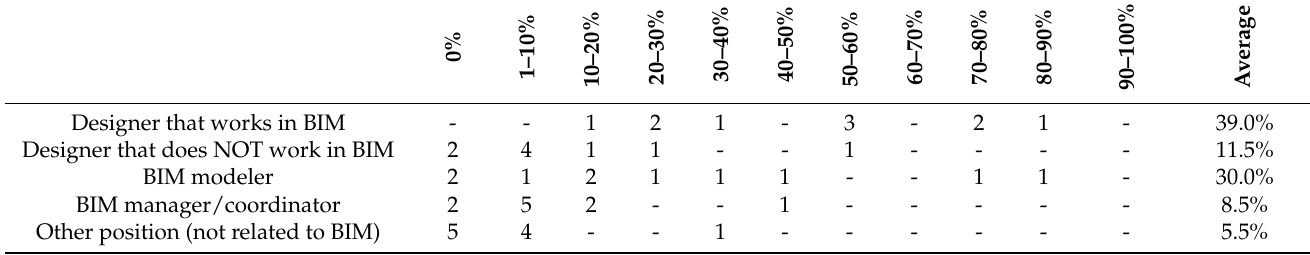
Table 4. Responses to the question: “What percentage representation had the positions in the team of the lead-appointed party? (e.g., 1 person of the team with 10 members = 10%)”.